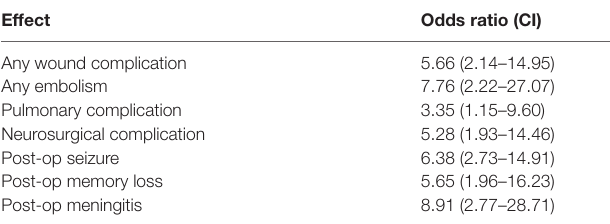
Table 5 | Stepwise logistic regression for predictors of 30-day readmission (adjusted for tobacco use, age ≥ 70, and sex).